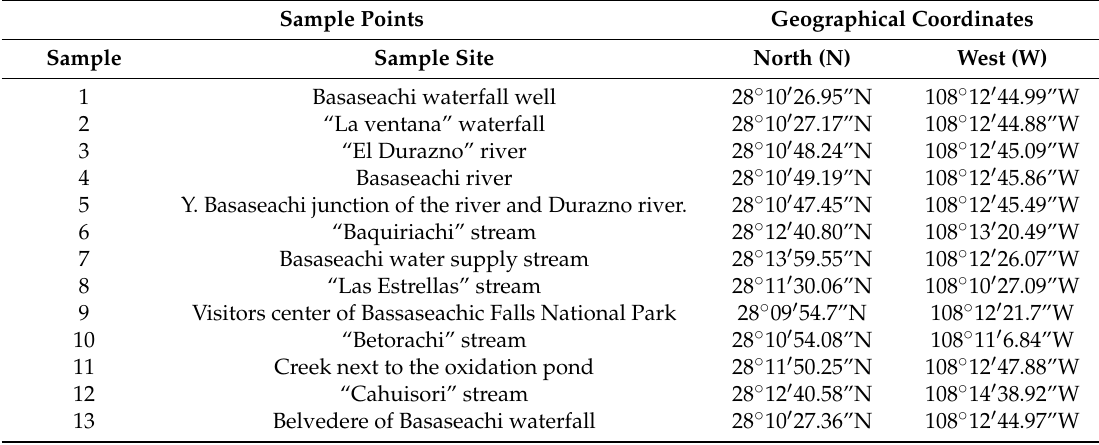
Figure 1. General scheme of Bassaseachic Falls National Park. The ( X ) symbols indicate the sampling sites: ( ● ) Rural se tt lement within the studied area. Source: INEGI digital map, Cartographic Package 2010; Scale 1:64140. Samples 5 (28°10 ′ 47.45 ″ N, 108°12 ′ 45.49 ″ W) and 6 (28°12 ′ 40.80 ″ N, 108°13 ′ 20.49 ″ W) were lost during the summer, and sample 13 was lost during the spring (28°10 ′ 27.36 ″ N, 108°12 ′ 44.97 ″ W). Table 1. Description of the freshwater sample sites at Bassaseachic Falls National Park during 2013. Sample Points Geographical